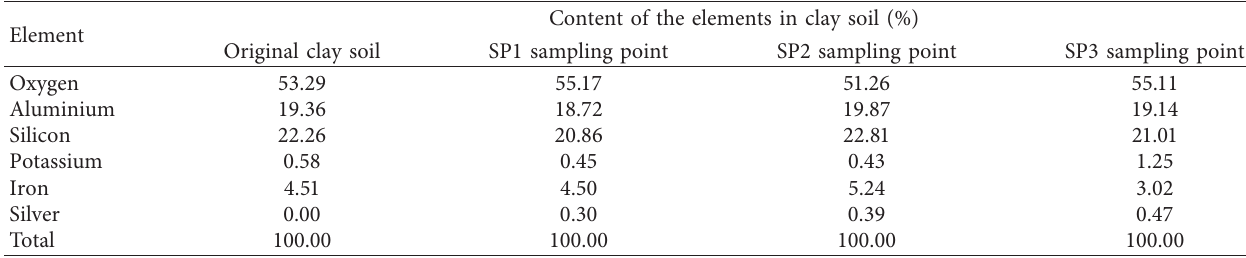
Table 3: Elemental analysis of clay soil at different sampling